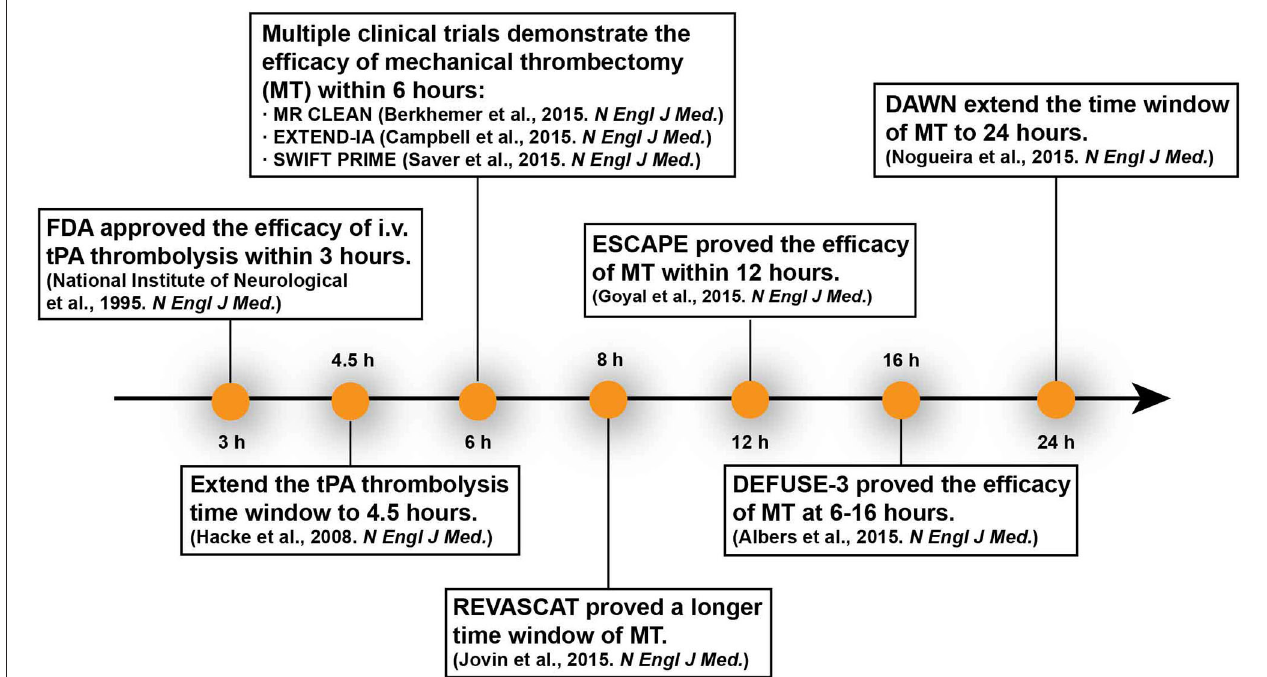
FIGURE 1 | Evolution of the time window for recanalization therapies.